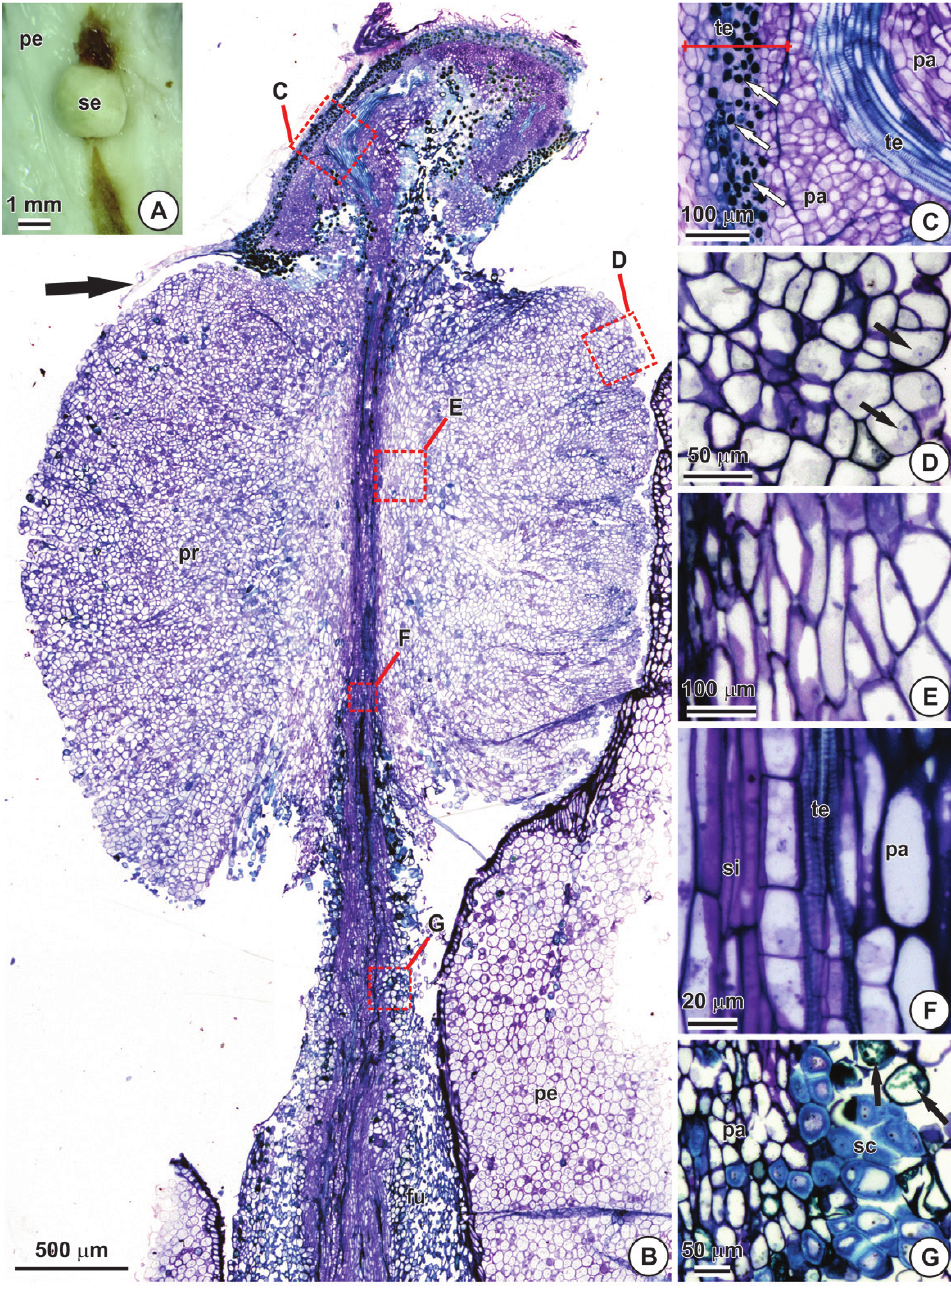
Figure 4 - Sterile seeds from the mature fruit of an aspermic Annona squamosa mutant. External appearance in lateral view (A) . Longitudinal section, showing the site of integument rupture (arrow) and detailed regions in C-G (outlined boxes) (B) . Micropylar region showing idioblasts with phenolic content (arrows) and the extension of the integument (red line) (C). Peripheral region of the perisperm highlighting prominent nuclei in cells with dense cytoplasm (arrows) (D) . Elongated parenchyma cells in the central region of the perisperm (E) . The vascular column in the central region of the perisperm (F) . Middle region of the funiculus, featuring idioblasts with phenolic content (arrows). pa , parenchyma cells; pe , pericarp; pr , perisperm; sc , sclereids; se , seed; si , sieve elements; te , tracheal